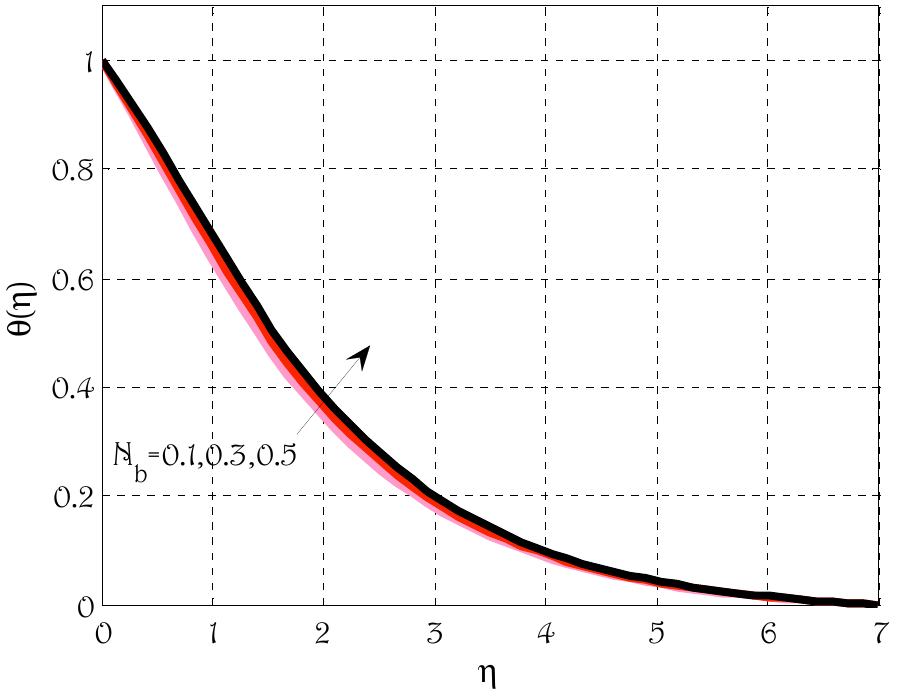
Figure 7. Effect of Brownian motion parameter N b on temperature profile θ using k p = 0.5, M = 0.5, R d = 0.7, λ = 0.1, E c = 0.1, N t = 0.1, P r = 1.9, S c = 1.4, γ =